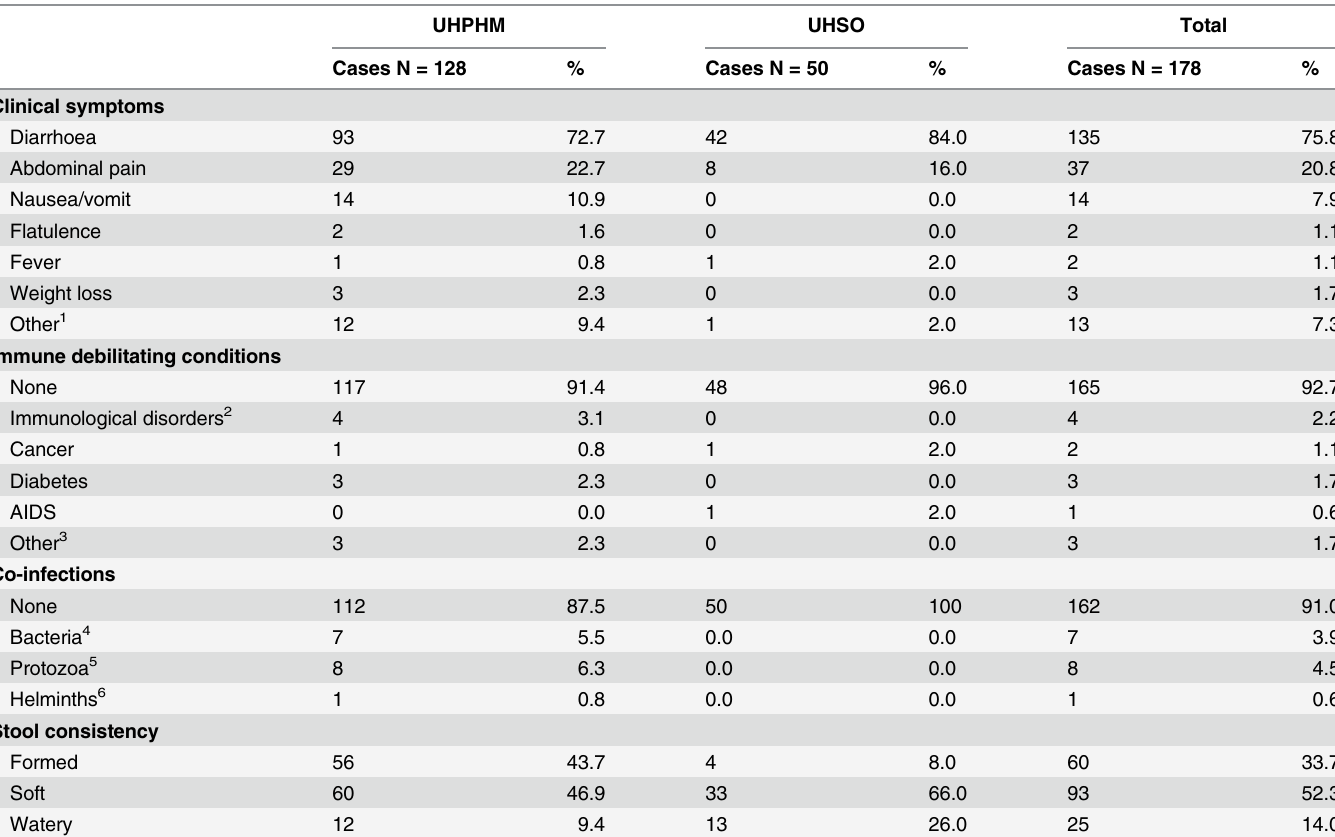
Table 2. Clinical parameters in symptomatic patients with confirmed giardiasis attended at the University Hospitals Puerta de Hierro Majadahonda (UHPHM) and Severo Ochoa (UHSO), Madrid, December 2013 – January